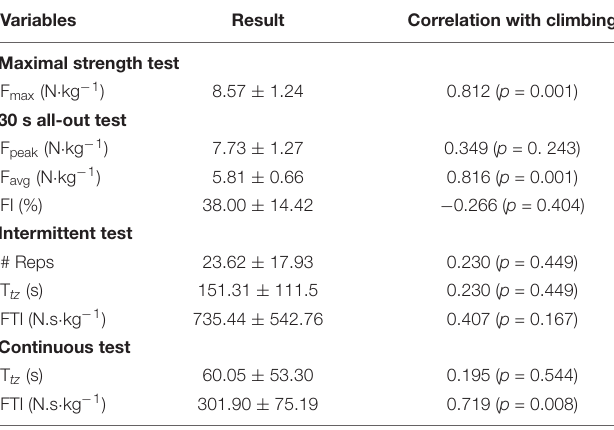
TABLE 2 | Results of exercise tests (mean ± SD for all